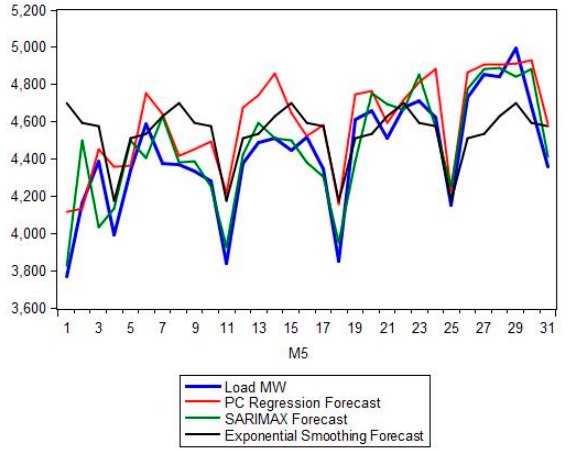
Figure 21. Forecast accuracy comparison for May 2014 for the Greek electricity market. Energies 2016 , 9 , 635